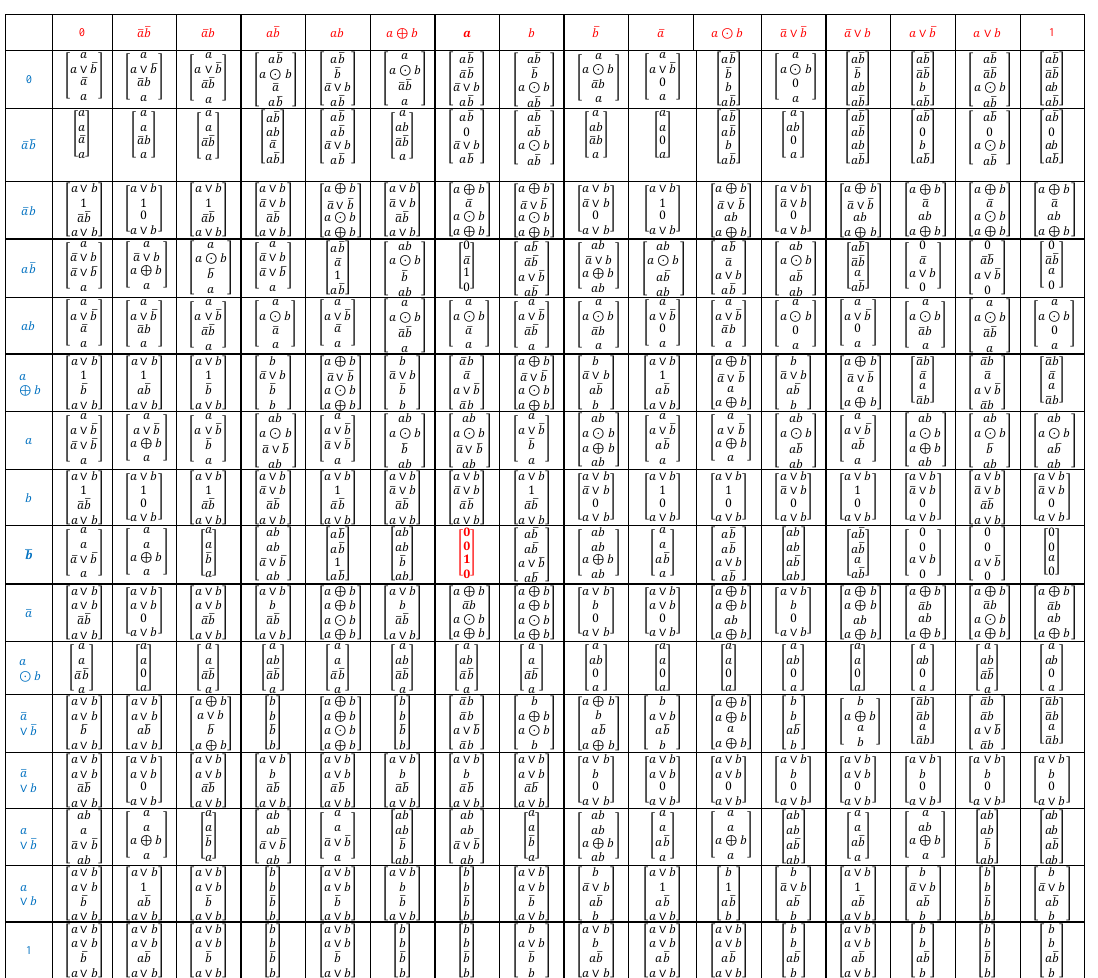
Table 3. All the 256 4-tuples to be obtained by the